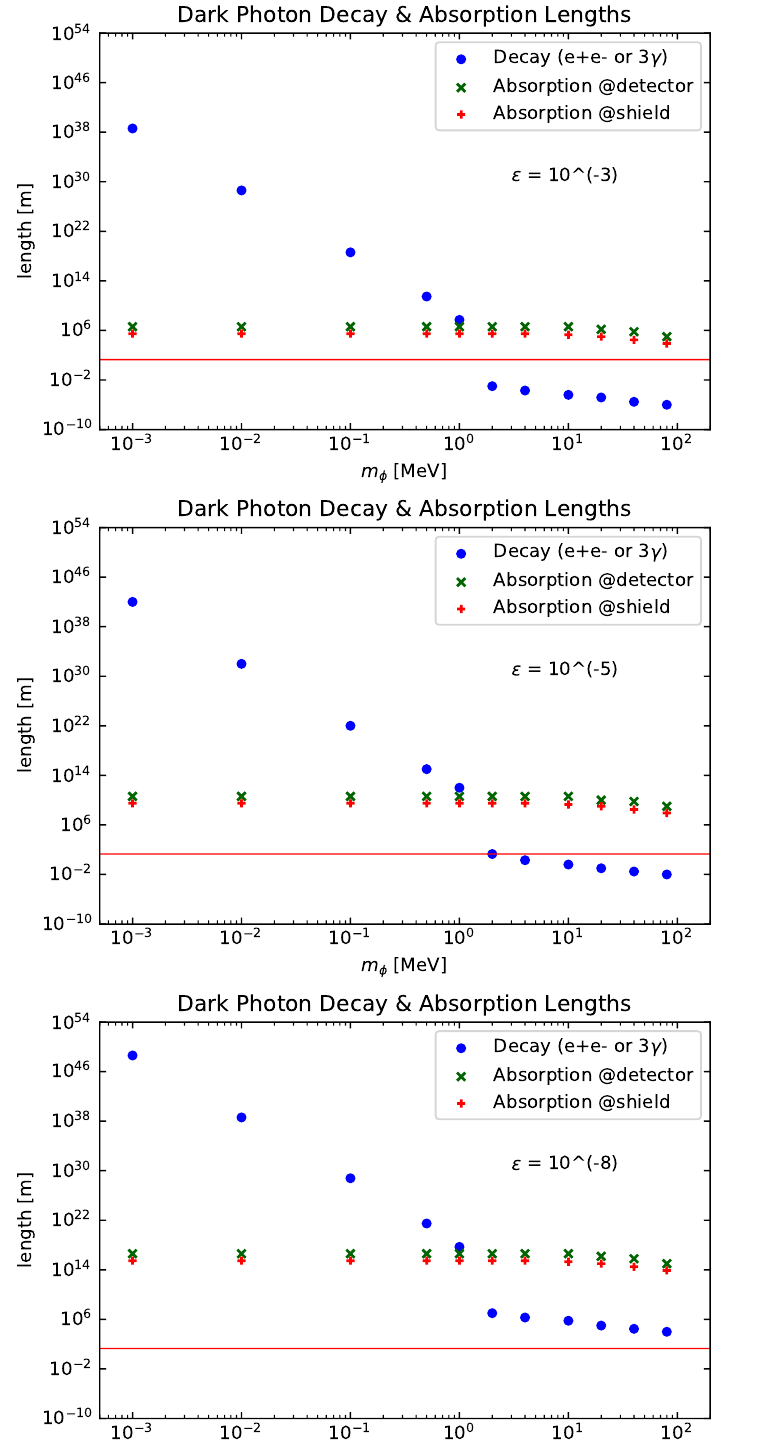
Figure 8 . Dark photon decay and absorption lengths in the Yemilab setup for a 100 MeV–100 kW e − beam incident on a tungsten target (50 cm). The horizontal red line represents the diameter of the neutrino detector that is assumed in this